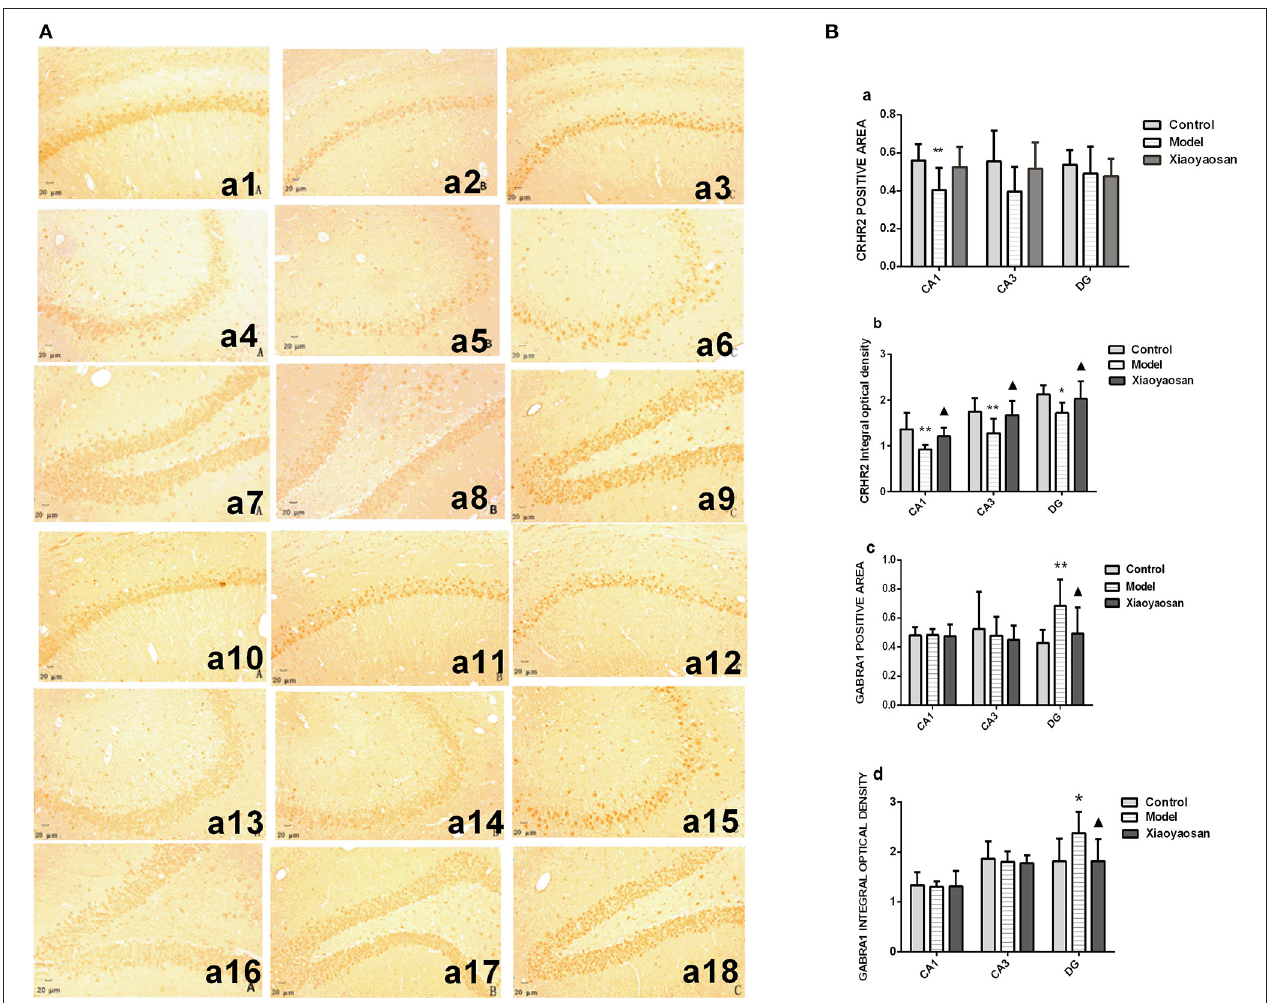
FIGURE 4 | Effects of Xiaoyaosan on the expression of the CRHR2 and GABRA1 mRNAs in the rat hippocampus. (A) The expression of the CRHR2 and GABRA1 mRNAs in the hippocampal CA 1 , CA 3 and DG regions. The expression of the CRHR2 mRNA in the hippocampal CA 1 (a1–a3) , CA3 (a4–a6) , DG (a7–a9) regions of the control, model, and Xiaoyaosan groups is shown. The expression of the GABRA1 mRNA in the hippocampal CA 1 (a10–a12) , CA3 (a13–a15) , DG (a16–a18) regions of the control, model, Xiaoyaosan groups is shown. (B) Changes in the expression of the CRHR2 and GABRA1 mRNAs in the rat hippocampus. (a) CRHR2-positive area in ISH. (b) Integrated optical density of the ISH for CRHR2. (c) GABRA1-positive area in ISH. (d) Integrated optical density of the GABRA1 ISH. Values are presented as the means ± SD from 10 rats per group. * P < 0.05 and ** P < 0.01 compared with the control group. N P < 0.05 compared with the model